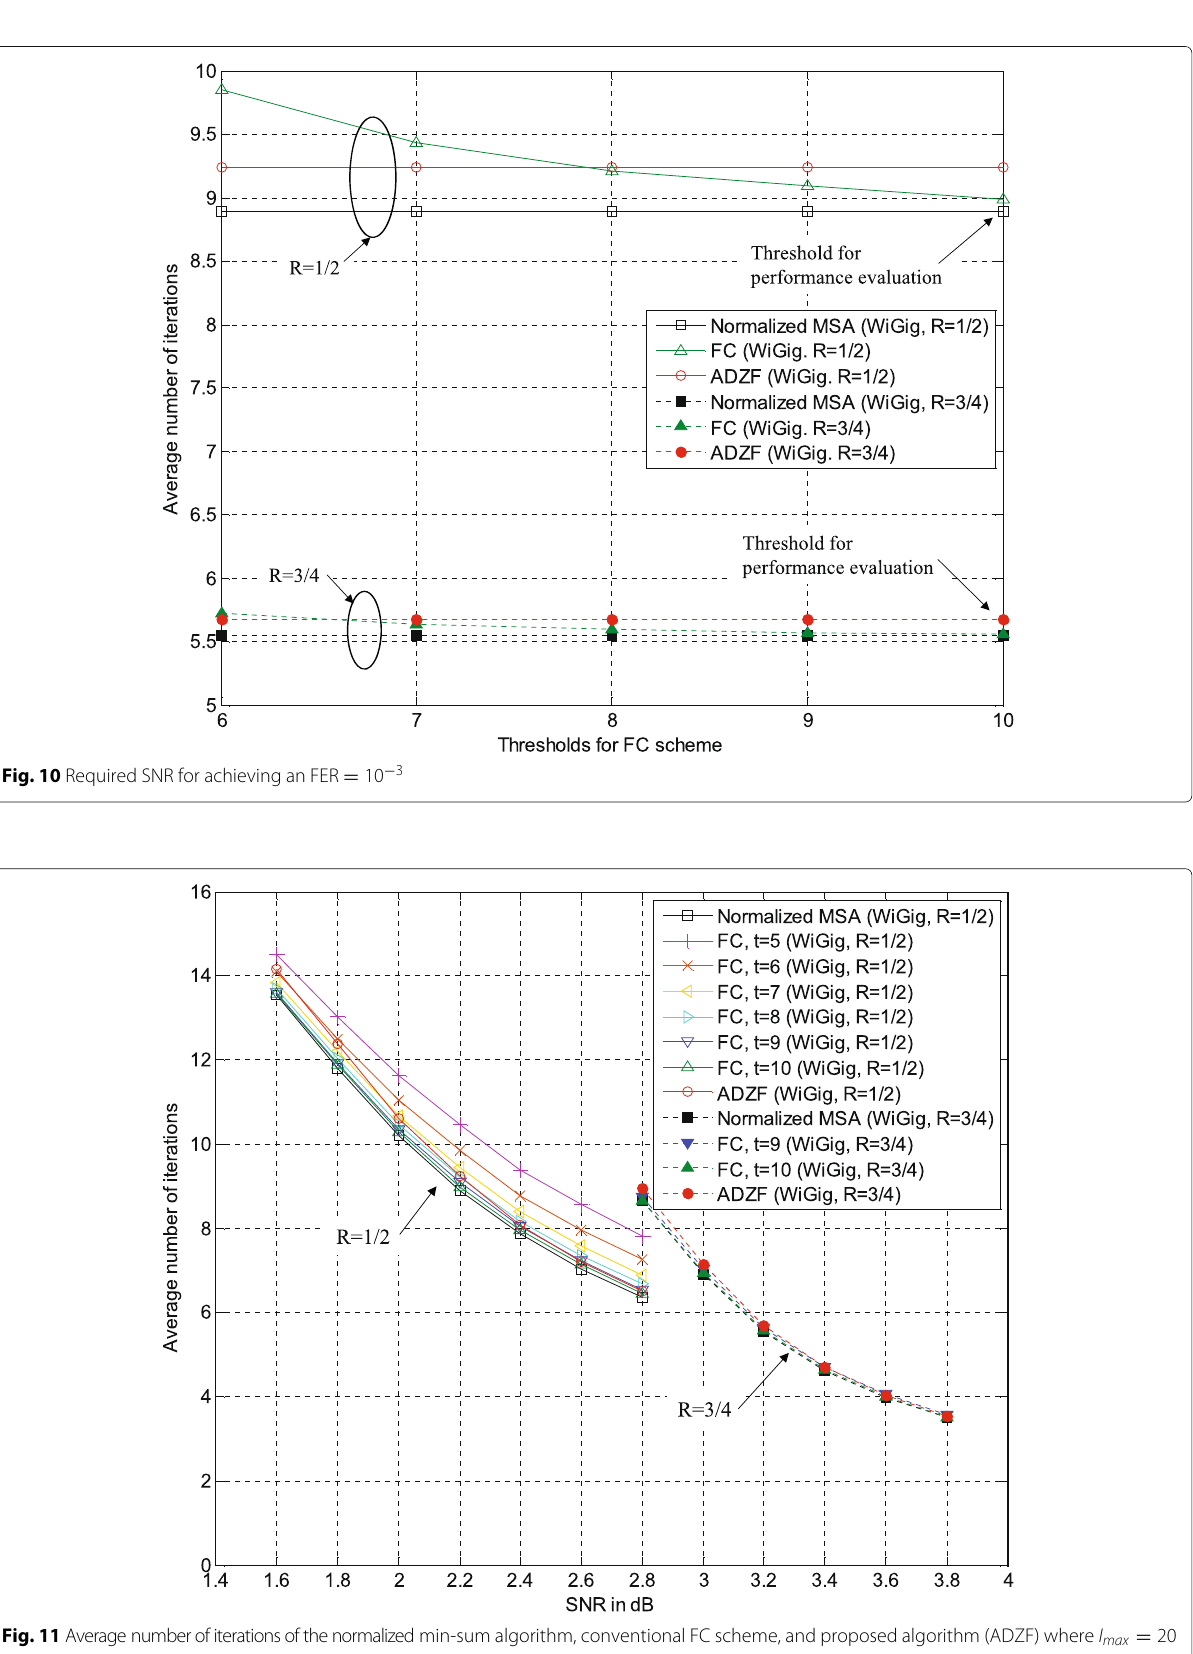
Fig. 11 Average numberofiterationsofthenormalized min-sum algorithm, conventional FC scheme, and proposed algorithm (ADZF) where I max =